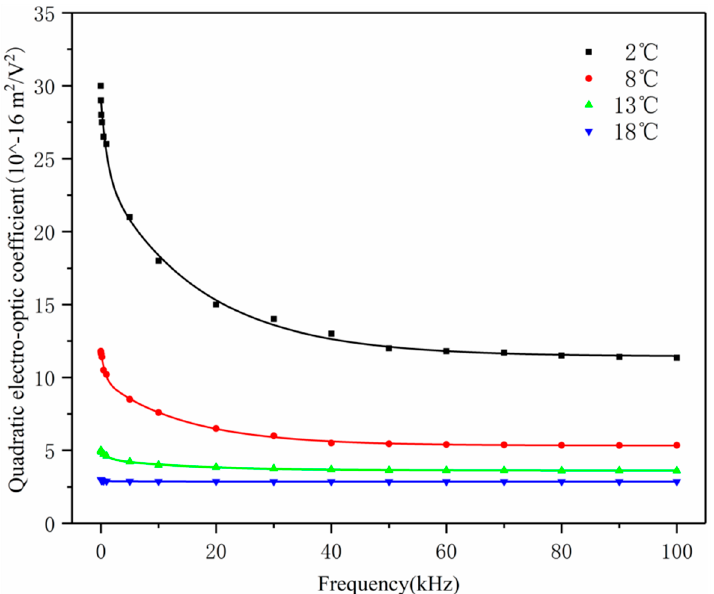
Figure 8. The quadratic electro-optic coefficients of AC modulation voltage frequency in the range of 10–100 kHz (the solid line is the fitting result).